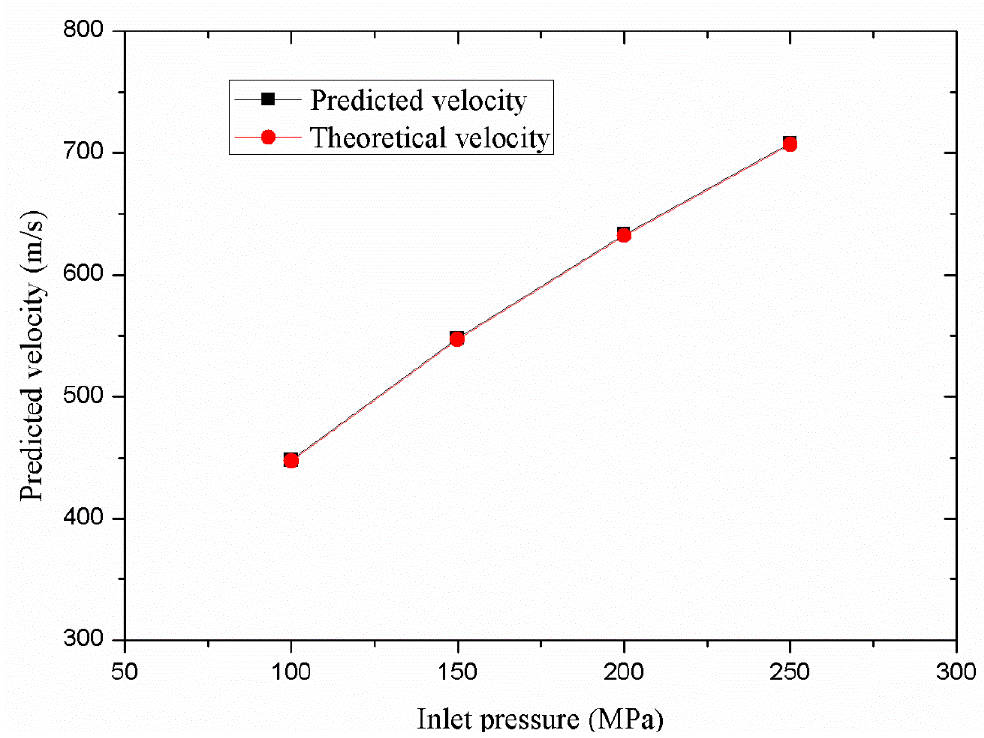
Figure 11. Comparison of the outlet velocity of the nozzle between theoretical result and numerical one.